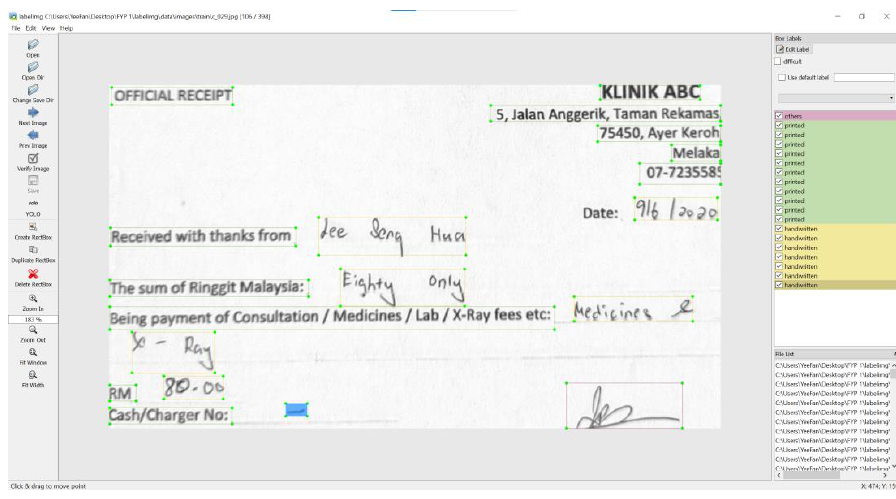
Figure 3. Sample labeled image.